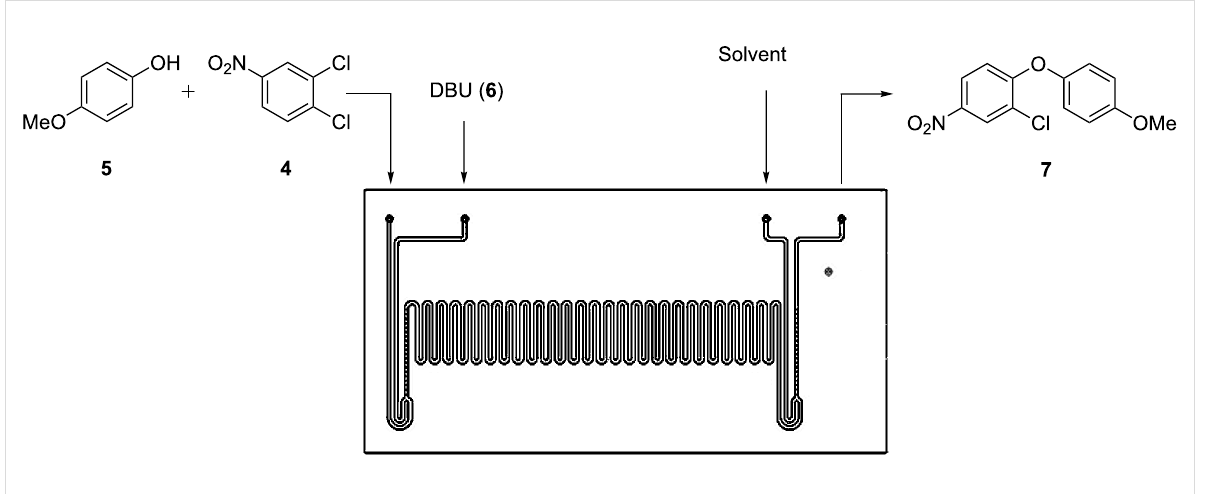
Figure 4: Schematic illustration of the reactor manifold used to evaluate the continuous-flow synthesis of 2-chloro-1-(4-methoxyphenoxy)-4-nitroben- zene ( 7 ) in the presence of DBU ( 6 ).